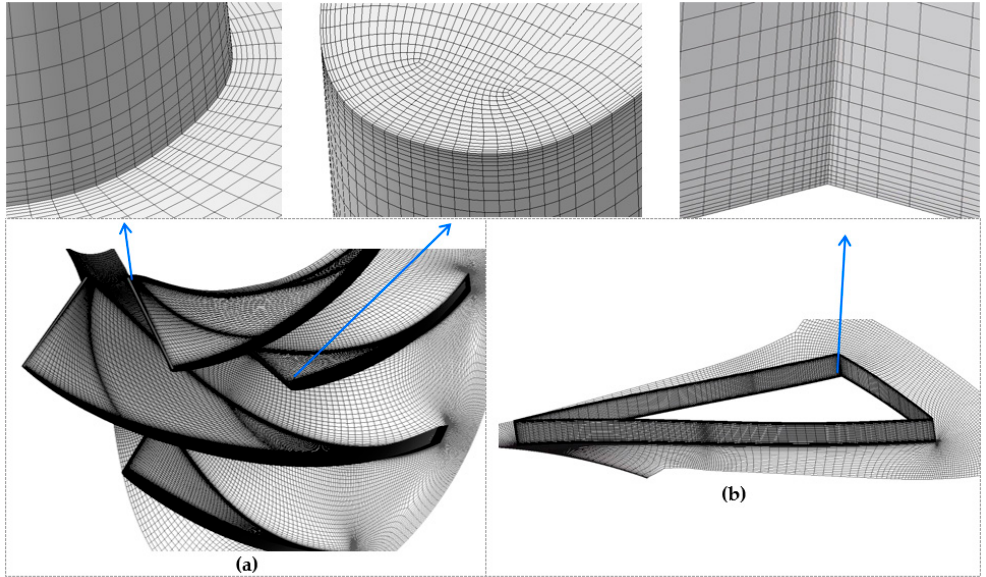
Figure 4. Computational meshes of the impeller and vaned diffuser: ( a ) Impeller; ( b ) Vaned diffuser. Table 2. Four types of RGP tables with the corresponding maximum Courant–Friedrichs–Lewy (CFL) numbers to achieve a convergent solution under design condition .